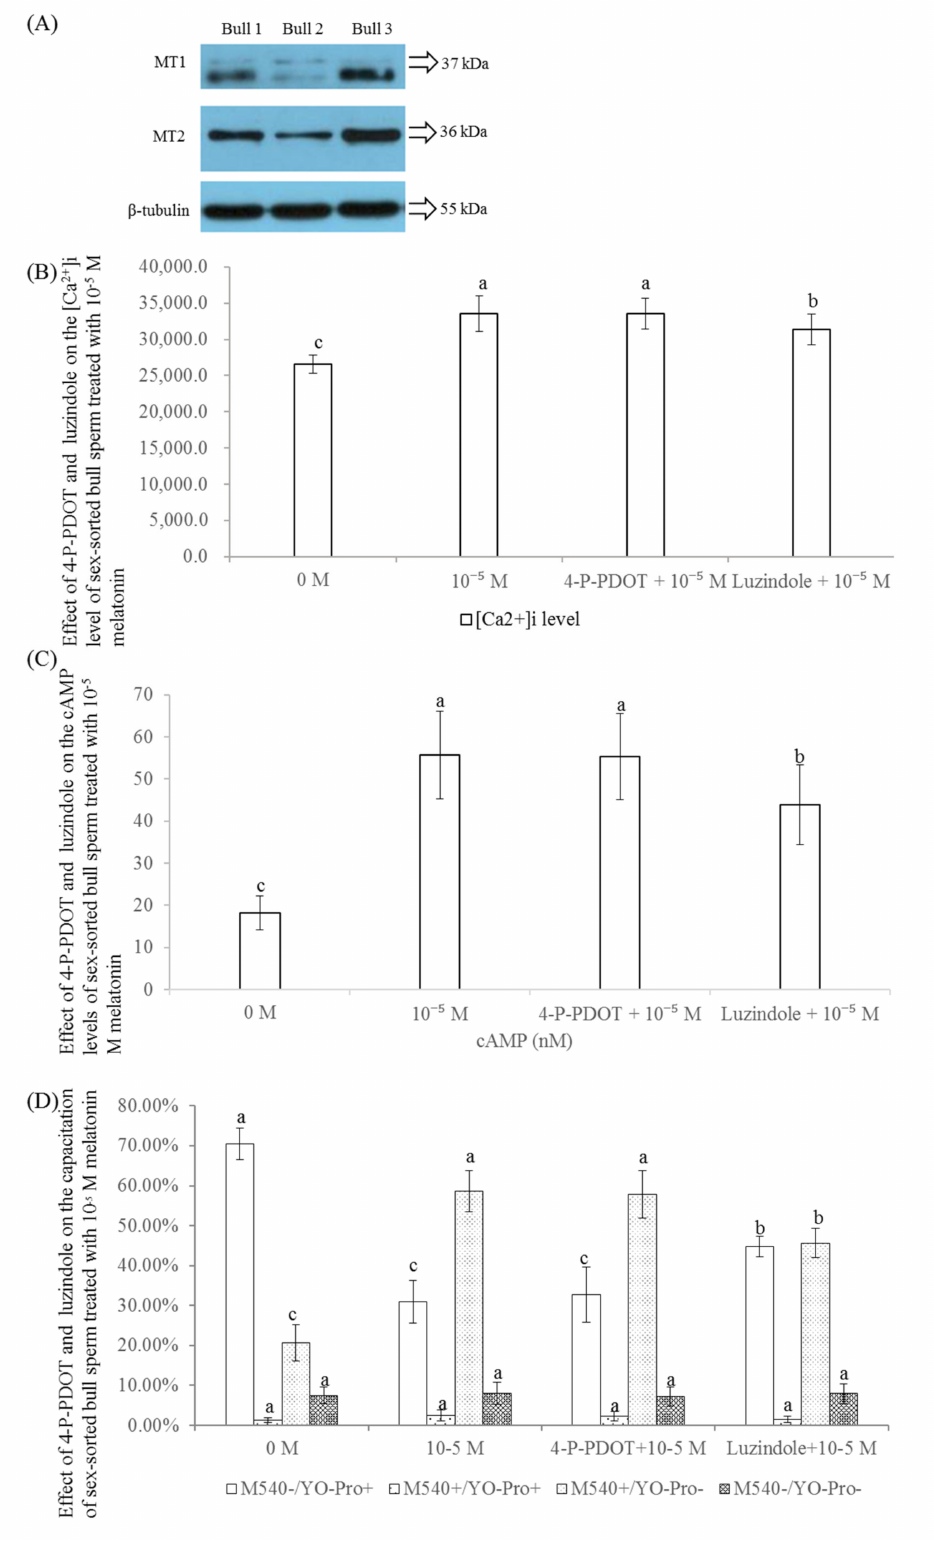
Figure 8. Effect of 4-P-POD and luzindole on the level of [Ca 2 + ] i , cAMP, and capacitation of sex-sorted bull sperm. ( A ) Western blot image of MT1 and MT2 protein expression. ( B ) Effect of 4-P-POD and luzindole on the level of [Ca 2 + ] i of sex-sorted bull sperm. ( C ) Effect of 4-P-POD and luzindole on the level of cAMP of sex-sorted bull sperm. ( D ) Effect of 4-P-POD and luzindole on the level of capacitation of sex-sorted bull sperm. Lowercase letters represent statistical significant difference ( p <